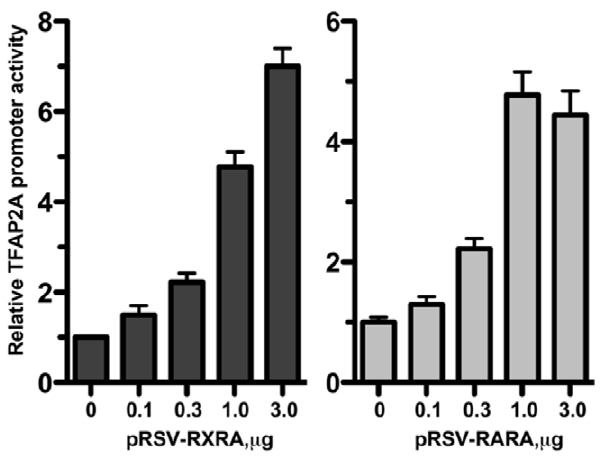
Figure 5. The effect of RXRA and RARA on TFAP2A promoter activity. JEG-3 cells were co-transfected with pGL3 b -TFAP2A-Luc and pRSV-RXRA or pRSV-RARA at the amounts indicated in the Figure. Each bar represents the mean of triplicate observations; and the bars enclose 1 SEM. Similar results were observed in two additional experiments.